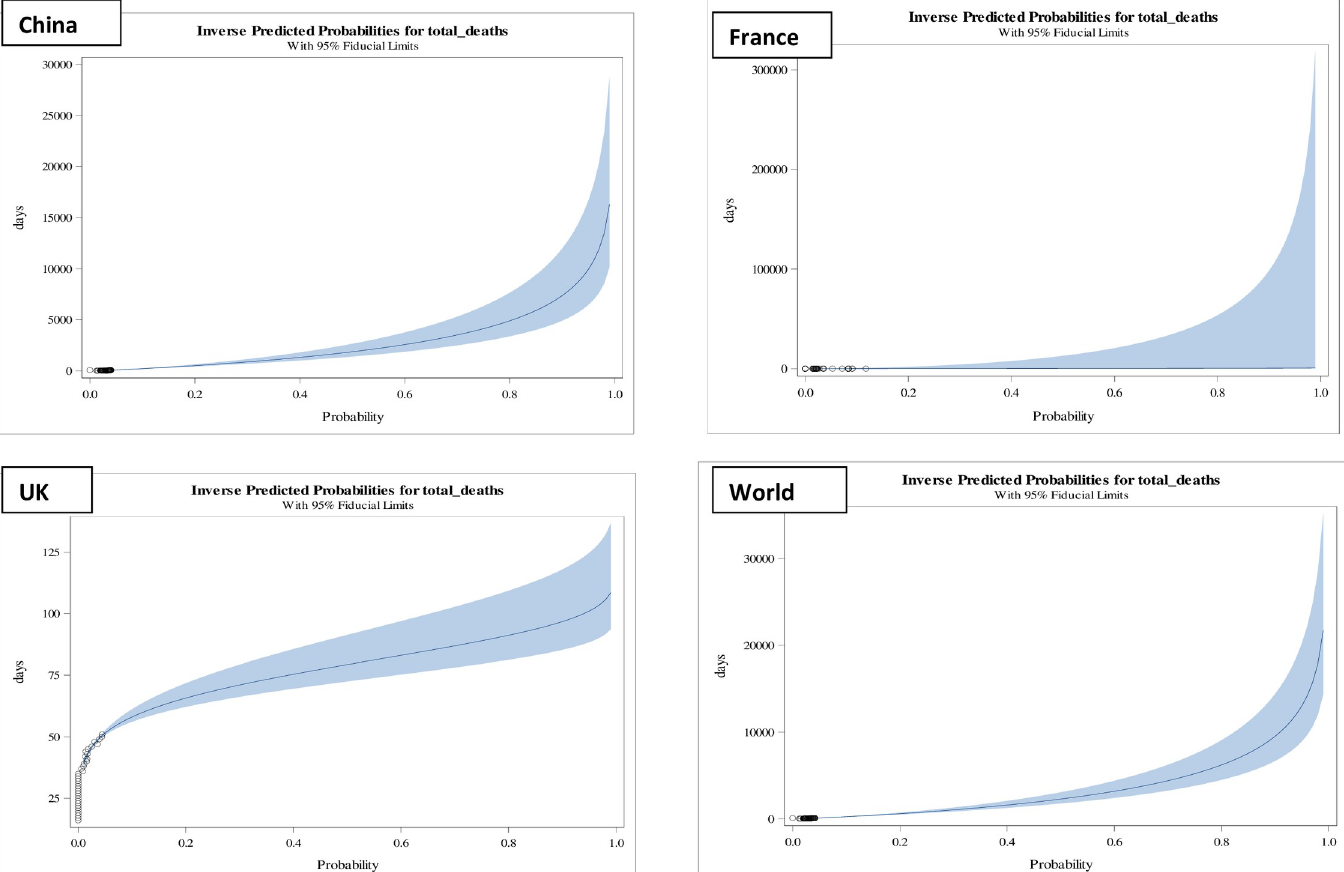
Fig 3. Inverse predicted probabilities of total deaths in counties, China, France, United Kingdom (UK) and World as a whole of Category II having Class 2 (0.06– 0.1) mortality rates.